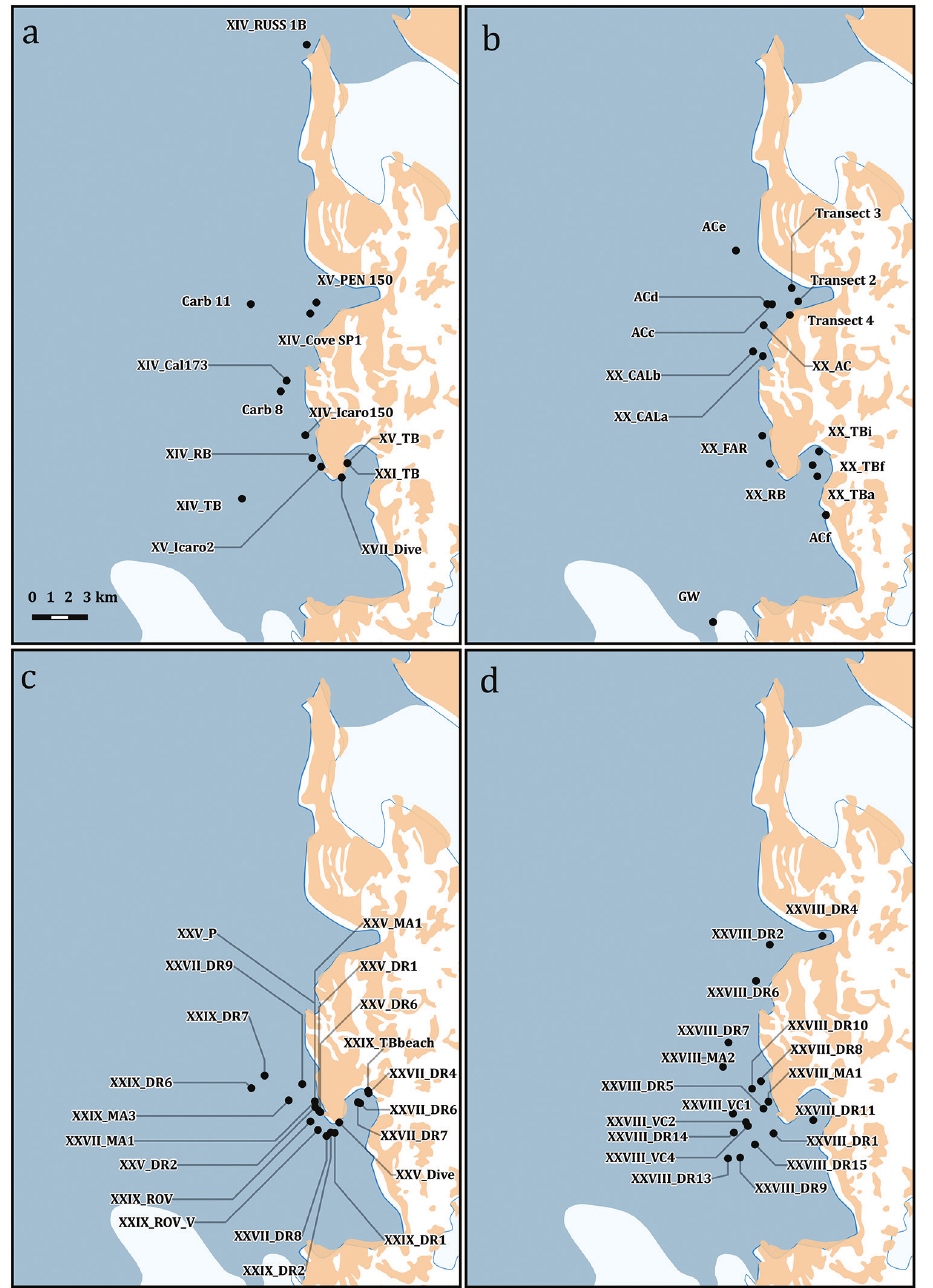
Figure 5. Detailed map of the sampling stations of the PNRA expeditions II XIV, XV, XVII, XX, XXI, XXV, XXVII, XXVIII,